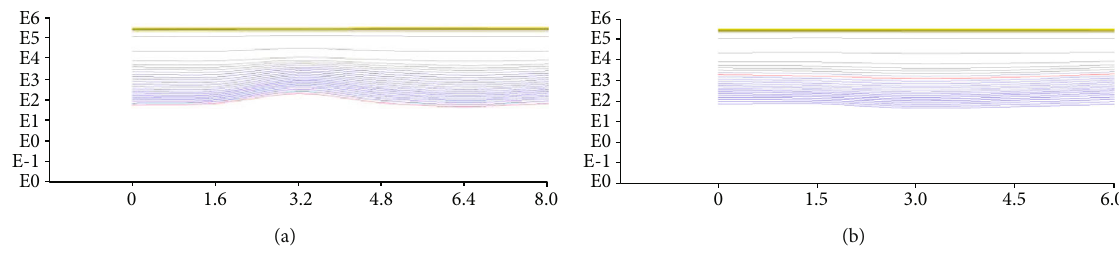
Figure 10: Graph of induced electromotive force: (a) line 1 and (b) line 2.